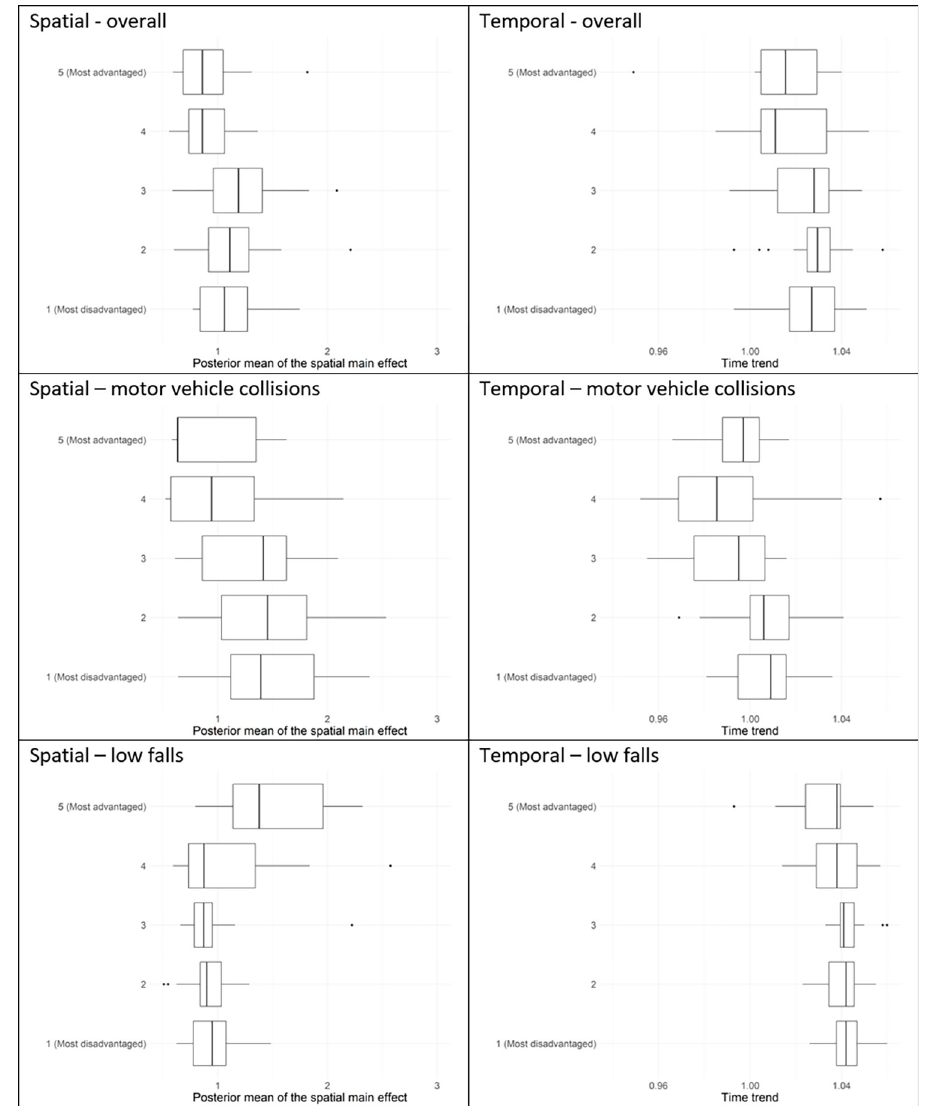
upper box ranges reflecting lower and upper quartile, respectively. The upper/lower whiskers reflect the largest/ smallest observation less than or equal to ± 1.5 times the interquartile